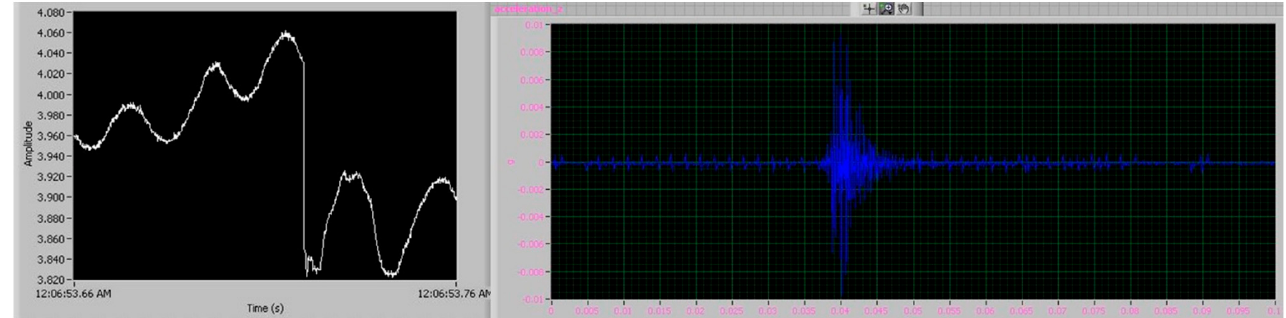
Figure 2. Experimental setup for impact hammer testing. (a) Setup (b) Setup - Vice (c) Impact Testing (d) Impact test- Figure 3. Impact hammer ( left ) and accelerometer ( right ) signals during impact testing for determi- ing, 2 nd photograph